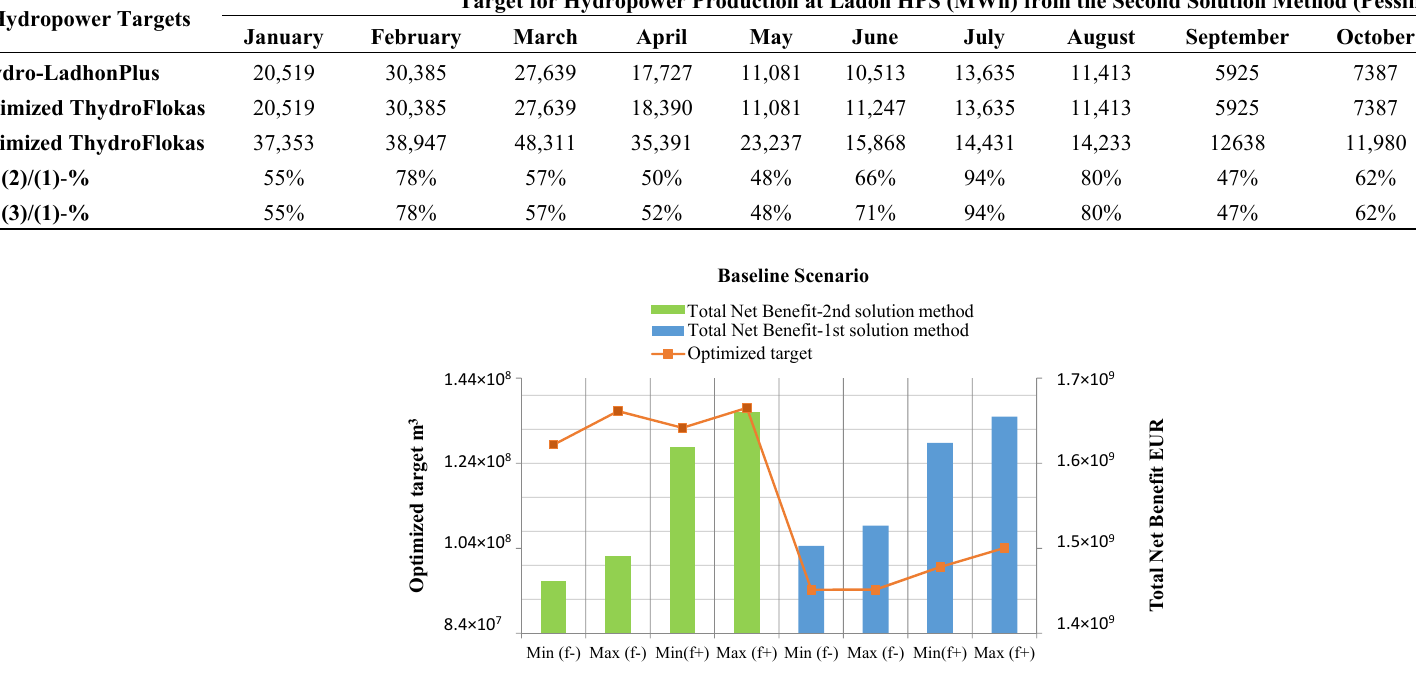
Table 20. Maximum allowable (THydro-LadhonPlus) and minimum (MinOptimized THydroFlokas) and maximum (MaxOptimized THydroFlokas) optimized monthly targets of hydropower production at Flokas HPS (MWh) and their ratios in (%) for the second solution method (pessimistic).